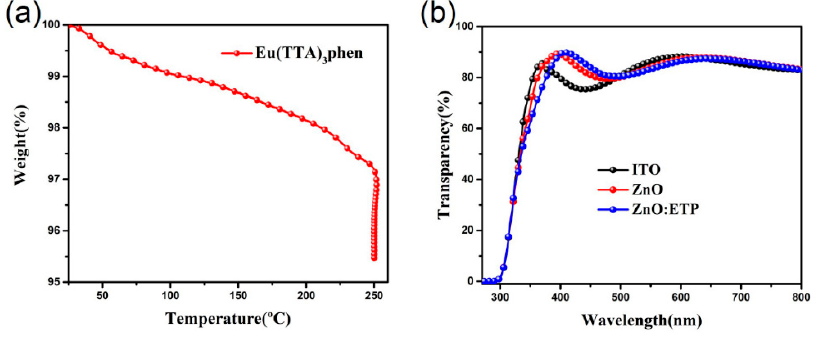
Figure 6. ( a ) TGA spectra of ETP complexes, heating rate (15 °C/min), 250 °C for 20 min; ( b ) transparency spectra of ITO, intrinsic ZnO, and ZnO/ETP films.